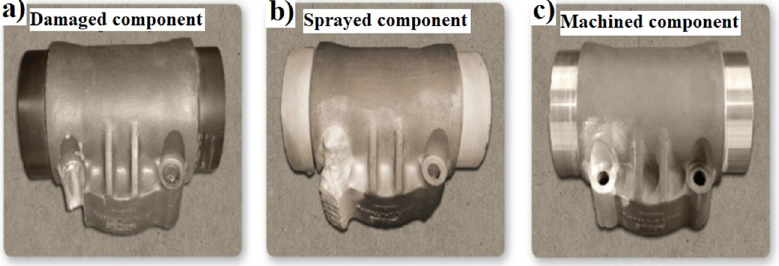
Figure 21: Repairing steps of a mechanical means deteriorated fl ap transmission tee box housing of an aero - plane by CSAM [ 69 ] .